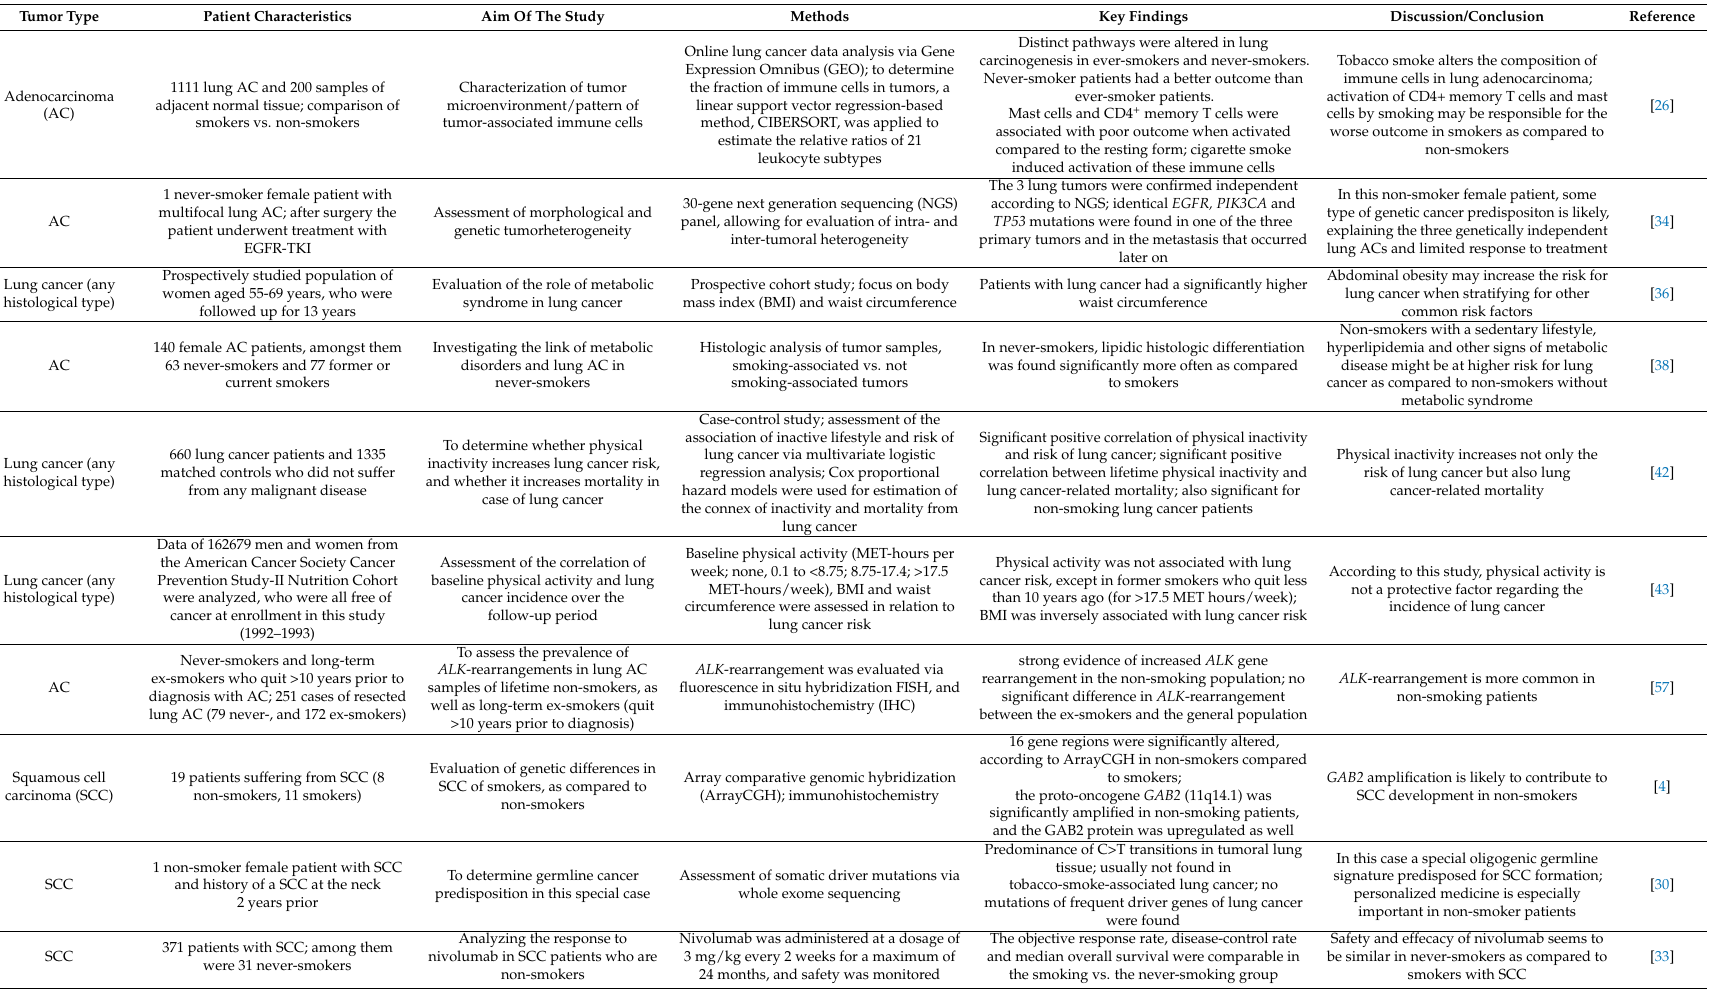
Table 1. Non-smoking associated lung cancer—summary of recent